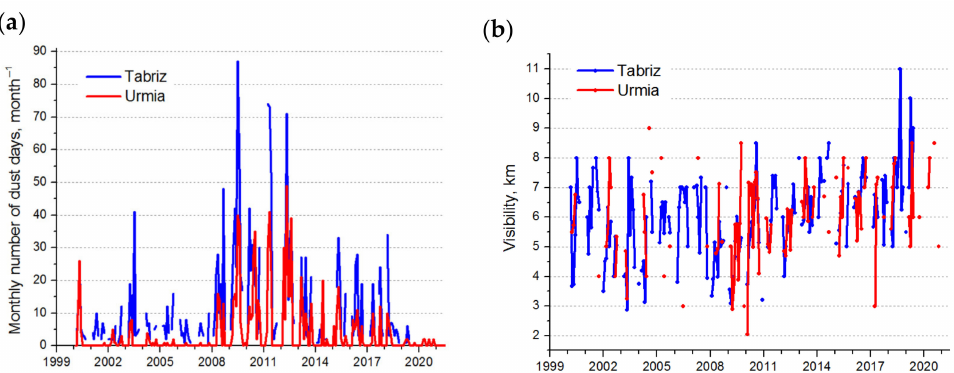
Figure 5. ( a ) The monthly number of dusty days at the weather stations Tabriz and Urmia in 2000–2020. ( b ) Monthly mean visibility at the weather stations Tabriz and Urmia in the dusty days in 2000–2020. Courtesy of Iran Meteorological Organization. Timestamps are related to